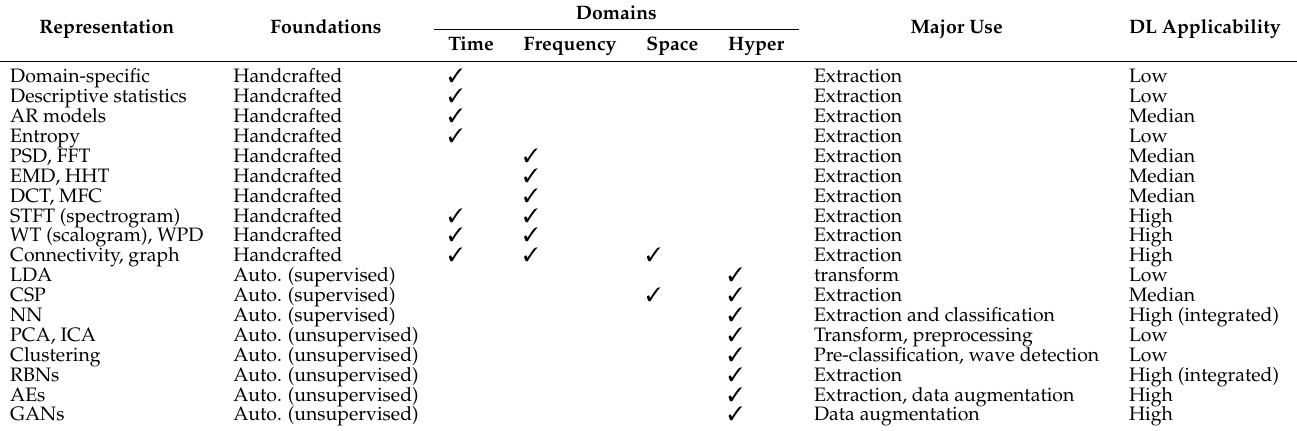
Table 4. Summary of representation extraction and learning methods discussed in this